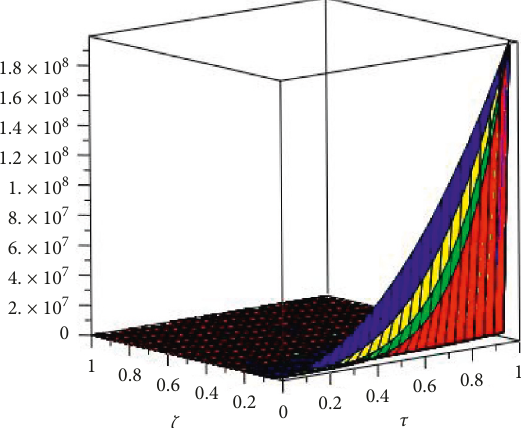
Figure 2: Figure of various fractional orders of Example